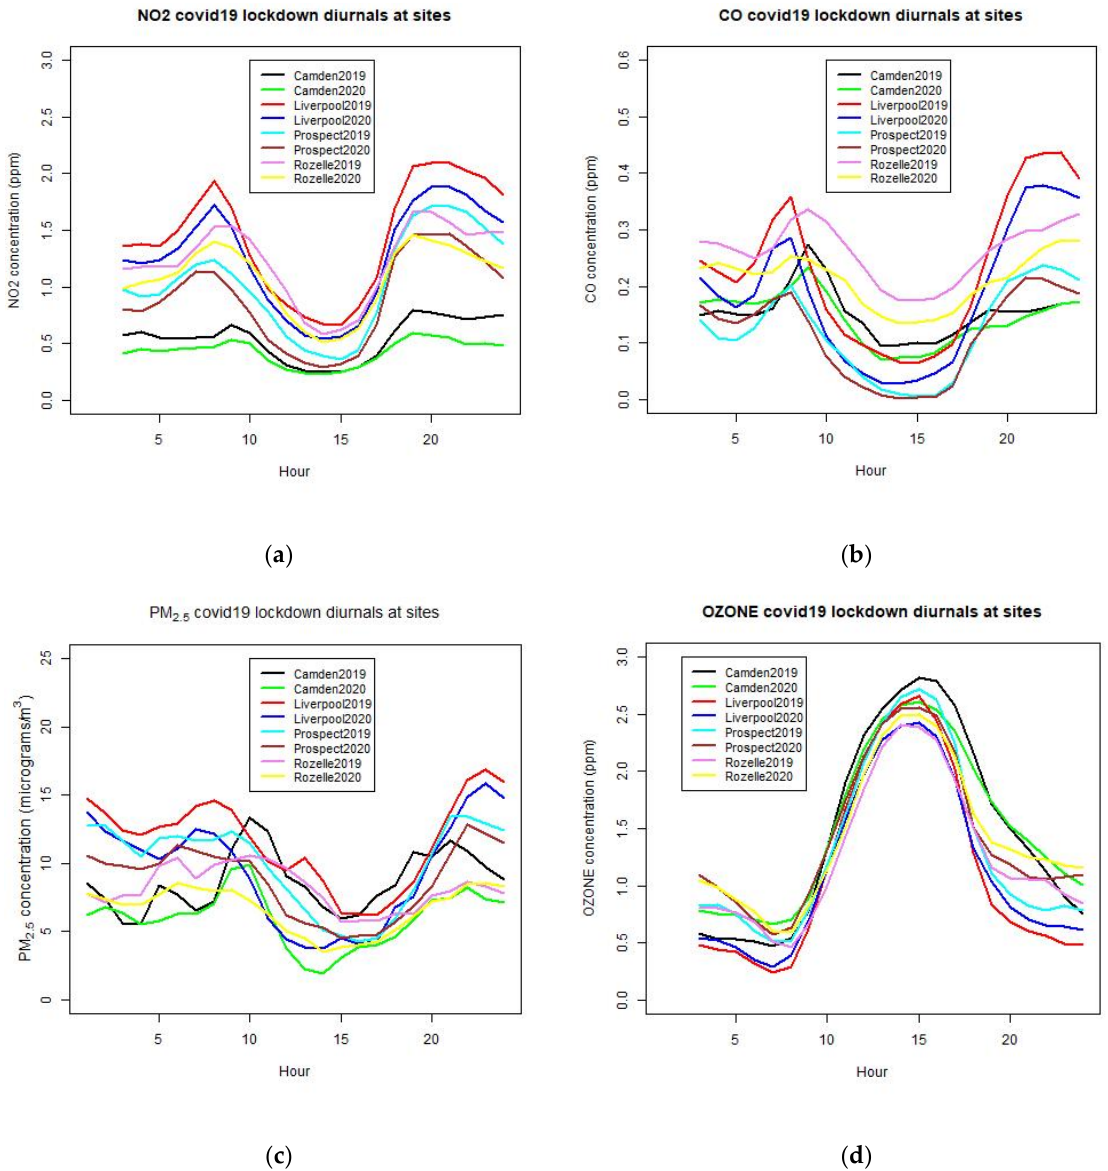
Figure 9. Diurnal patterns of NO 2 ( a ), CO ( b ), PM 2.5 ( c ), and O 3 ( d ) for 2019 and 2020 from April to June at different sites in the GMR.